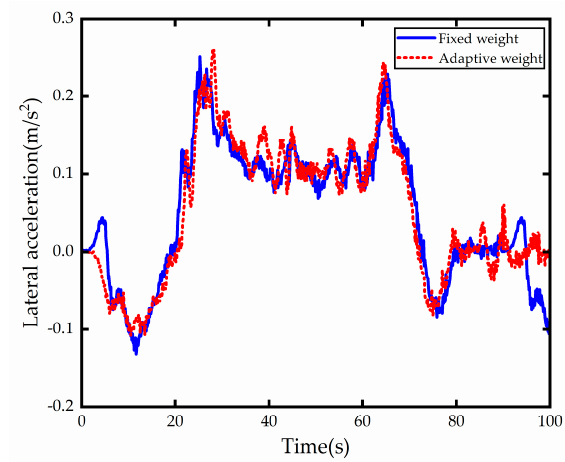
Figure 17. Tracking error comparison.